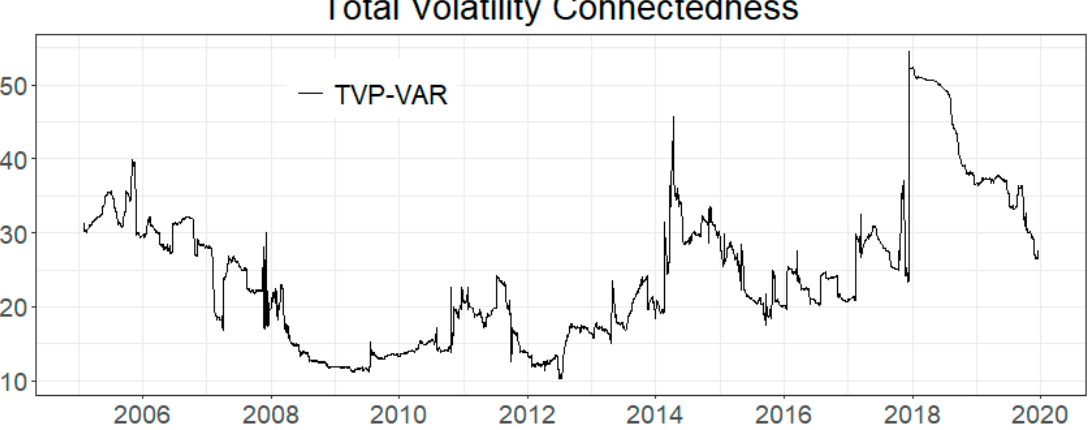
Figure 6. Time-varying total volatility connectedness. Note: the horizontal axis is the timeline; the vertical axis is the con- nectedness.